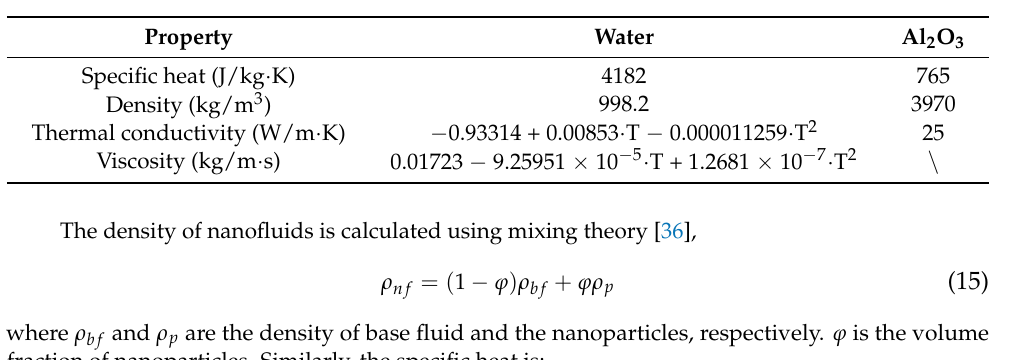
Table 2. Thermophysical properties of water and